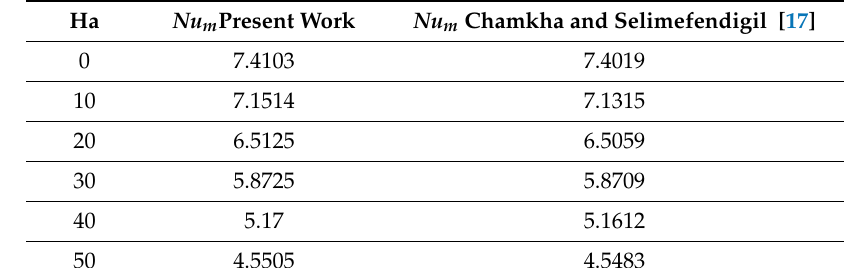
Table 4. Validation of numerical code.